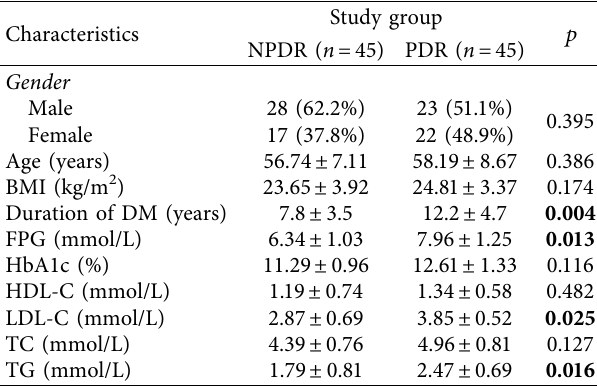
Table 1: Demographic and clinical characteristics of the study